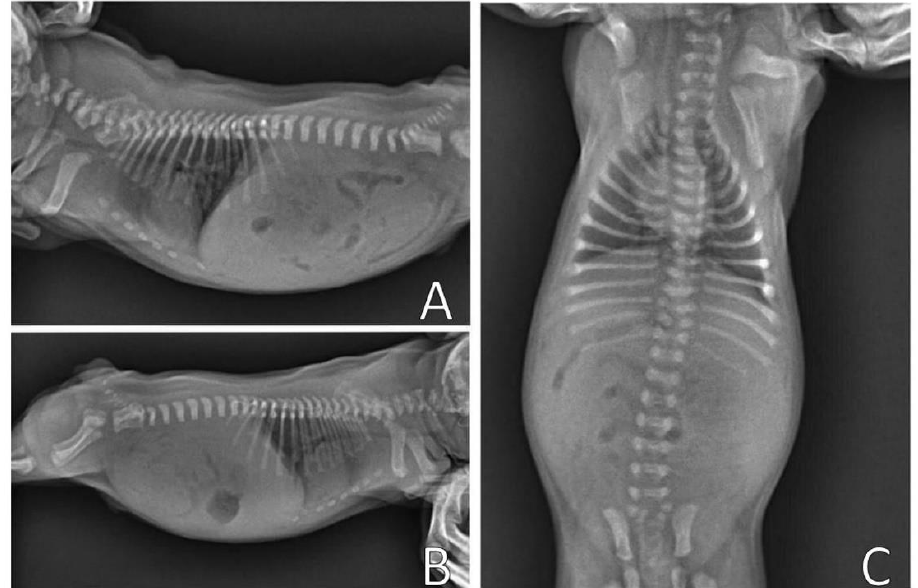
Figure 4. Normal thoracic radiographic examination. ( A ) Right side position; ( B ) Left side position; ( C ) Ventrodorsal position.